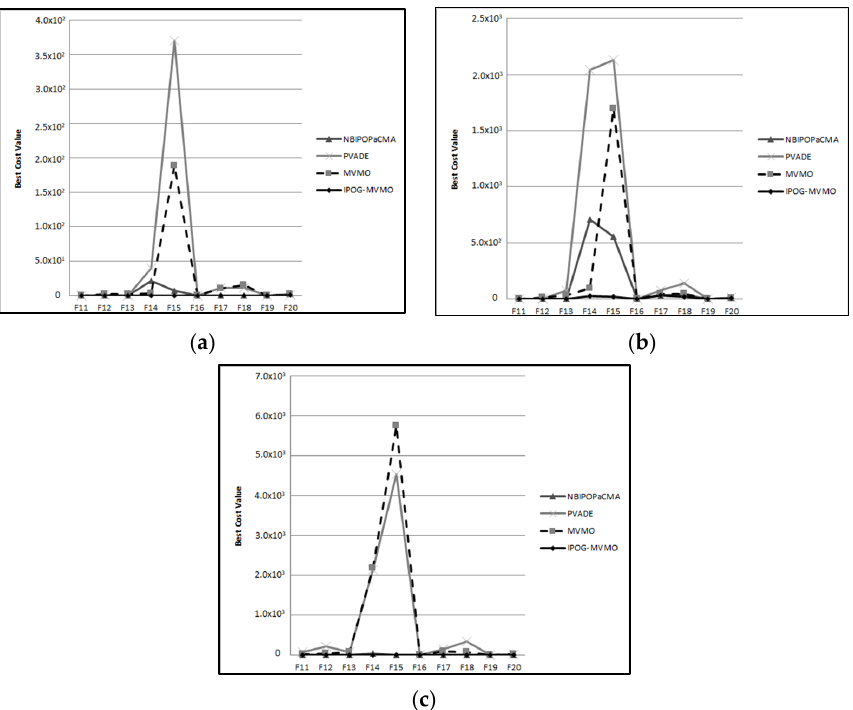
Figure 2. Comparison of the best cost value for F11–F20 at ( a ) 10 dimensions, ( b ) 30 dimensions, and ( c ) 50 dimensions.